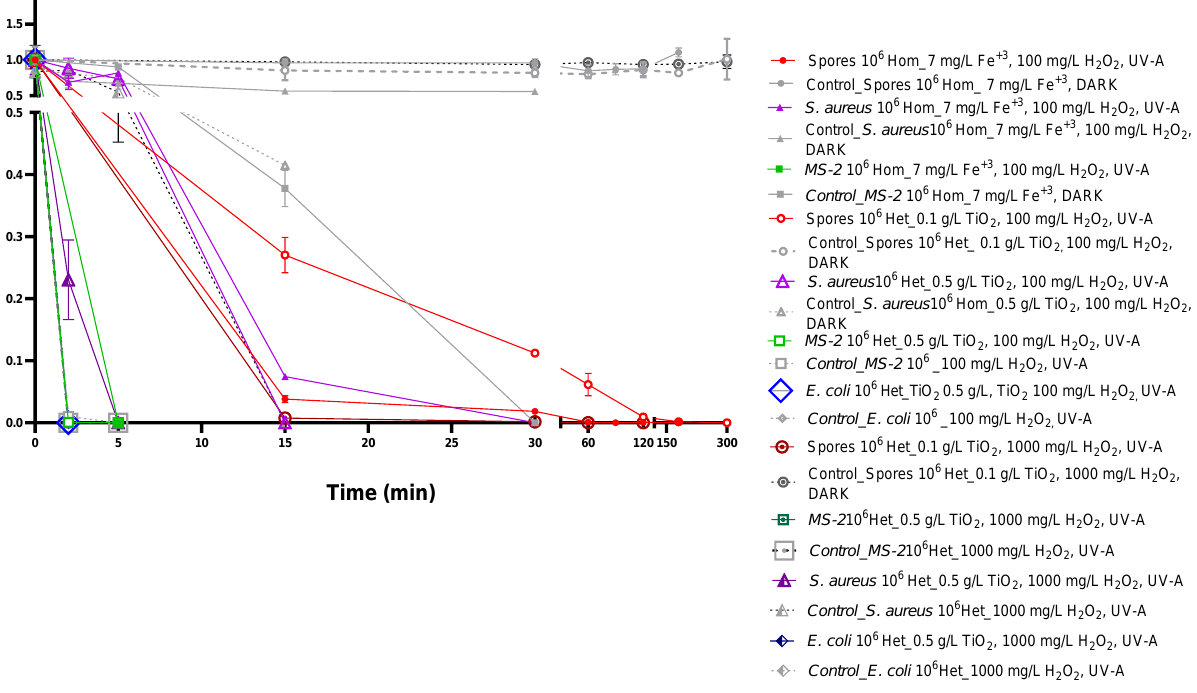
Figure 1. Homogeneous (7 mg/L Fe 3+ , 100 mg/L H 2 O 2 , pH 3.0, UV-A, solid symbols) and heterogeneous photocatalysis optimized for microorganism-dependent TiO 2 concentration (no fill symbols) supplemented with either 100 mg/L H 2 O 2 (continuous lines) or 1000 mg/L H 2 O 2 (dashed lines) for the inactivation of 10 6 cfu/mL Bacillus stearothermophilus spores (red), 10 6 pfu/mL MS2 (green), 10 6 cfu/mL Staphylococcus aureus (purple) and 10 6 cfu/mL Escherichia coli (blue). The graph depicts viability reduction (Nt/N0) of treated samples and corresponding controls (grey symbols and lines) in relation to processing time. Zero values in the Y axis represent cases for which no microorganism growth was detected (0 cfu/mL or pfu/mL). Error bars correspond to standard errors from triplicates. The legend shows experimental conditions for processed samples. Escherichia coli is highly susceptible at pH 3 required for homogeneous photocatalysis, and thus not included in these experiments.